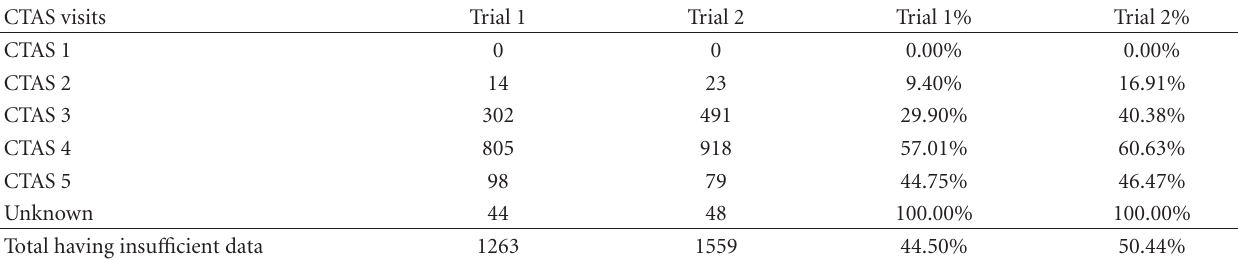
Table 2: Insu ffi cient data on chart as required by Canadian Triage and Acuity Scale (CTAS) guidelines (% of Table 1).